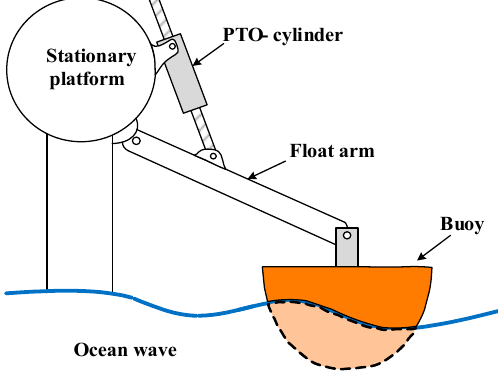
Figure 1. Point-absorber type wave energy converter (WEC).